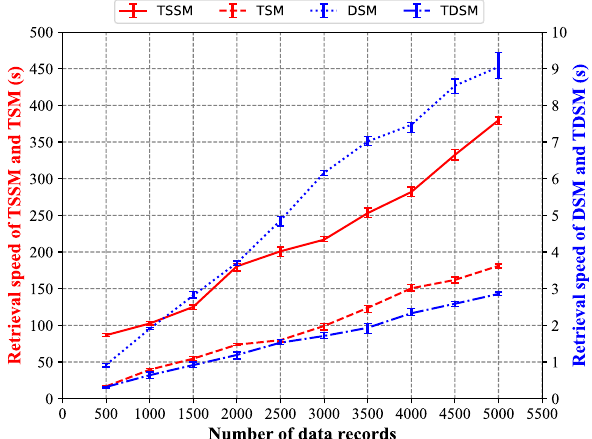
Figure 13. Comparison of data retrieval speed between TSSM, TSM, DSM and TDSM.